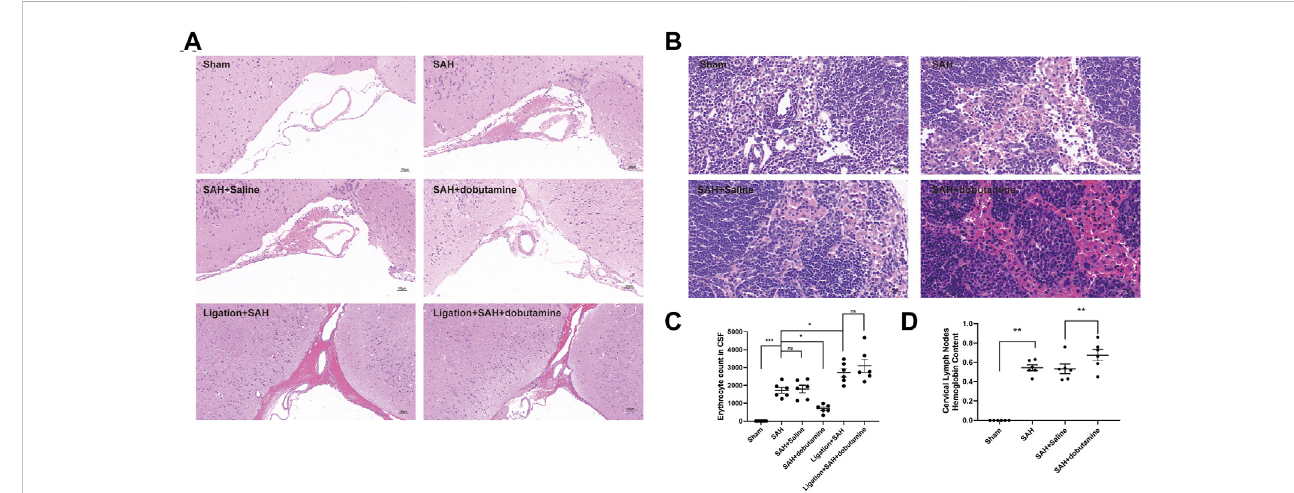
FIGURE 5 Dobutamine promoted the drainage of RBCs from SAS to dCLNs. (A) HE staining of RBC accumulation in the SAS in the sham, SAH, SAH + saline, SAH + dobutamine, ligation + SAH, and ligation + SAH + dobutamine groups. (B) HE staining of dCLNs showed decreased RBC accumulation in dCLNs after dobutamine administration. (C) Quantitative analysis of erythrocyte count in CSF. Data are presented as the mean ± SD ( n = 6 mice, ** p < 0.01, and *** p < 0.001). (D) Hemoglobin content of dCLNs after dobutamine administration was detected. Data are presented as the mean ± SD ( n = 6 mice and ** p < 0.01).